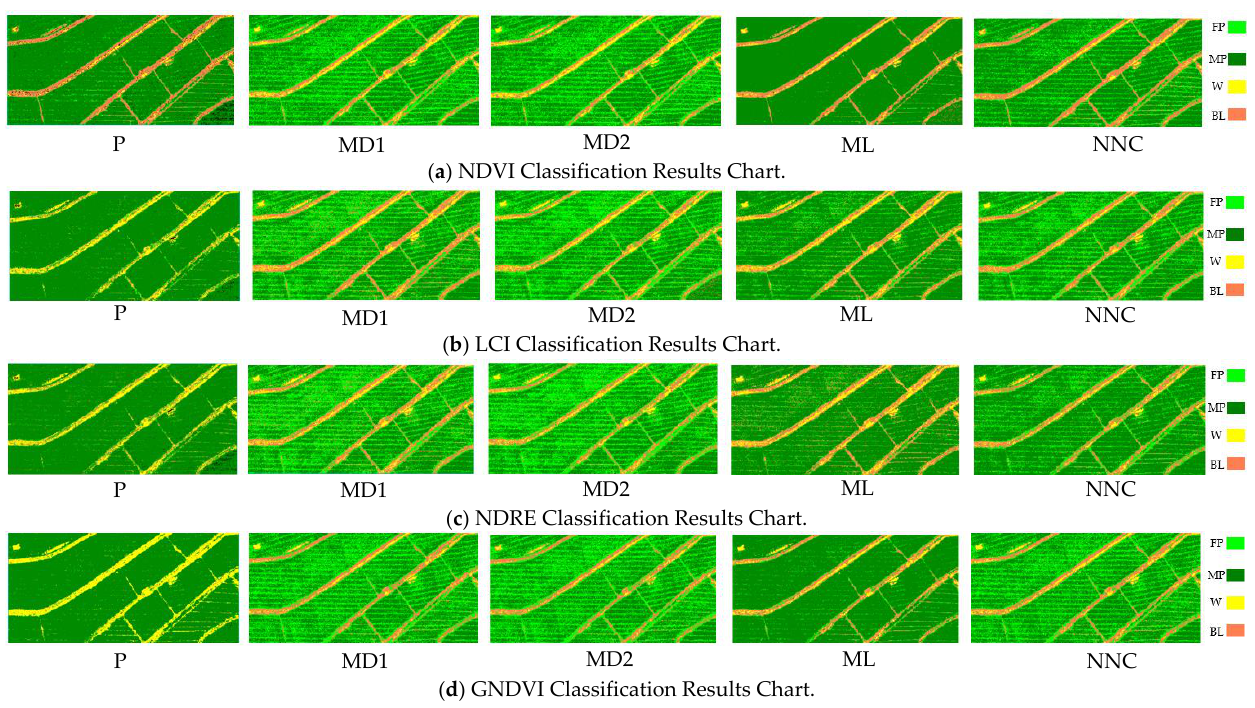
Figure 6. Supervised classification results of multispectral vegetation indices. FP: Female parent; MP: Male parent; W: Weed; BL: Bare land; P: Parallelepiped; MD1: Minimum Distance; MD2: Mahalanobis Distance; ML: Maximum Likelihood; NNC: Neural Network Classification.